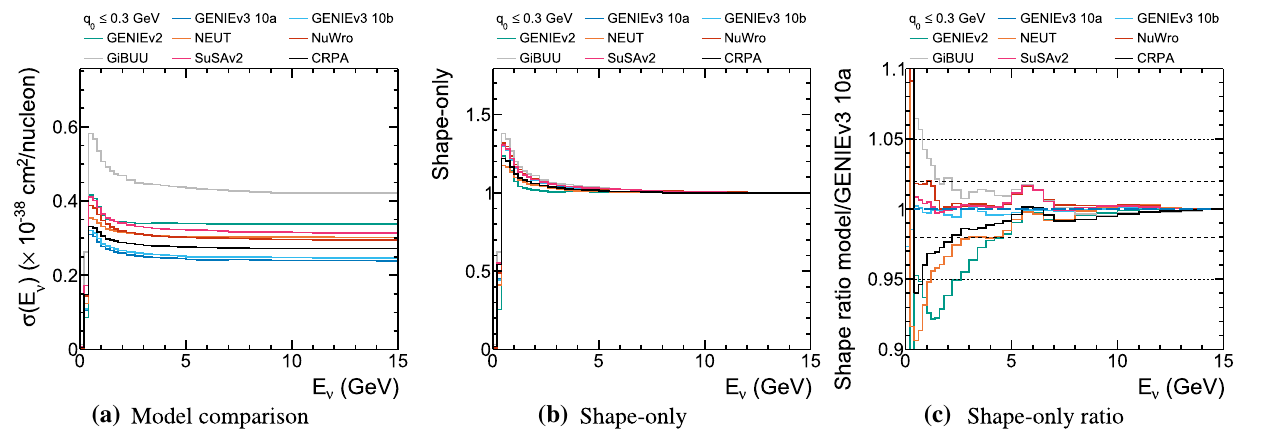
Fig. 3 Comparison of the total ν μ – 40 Ar charged-current cross section with true q 0 ≤ 0 . 3 GeV as a function of E true ν for all generator models considered (left); comparison of the shape of the same cross section, normalized such that the 14–15 GeV bin is 1 (middle); comparison of